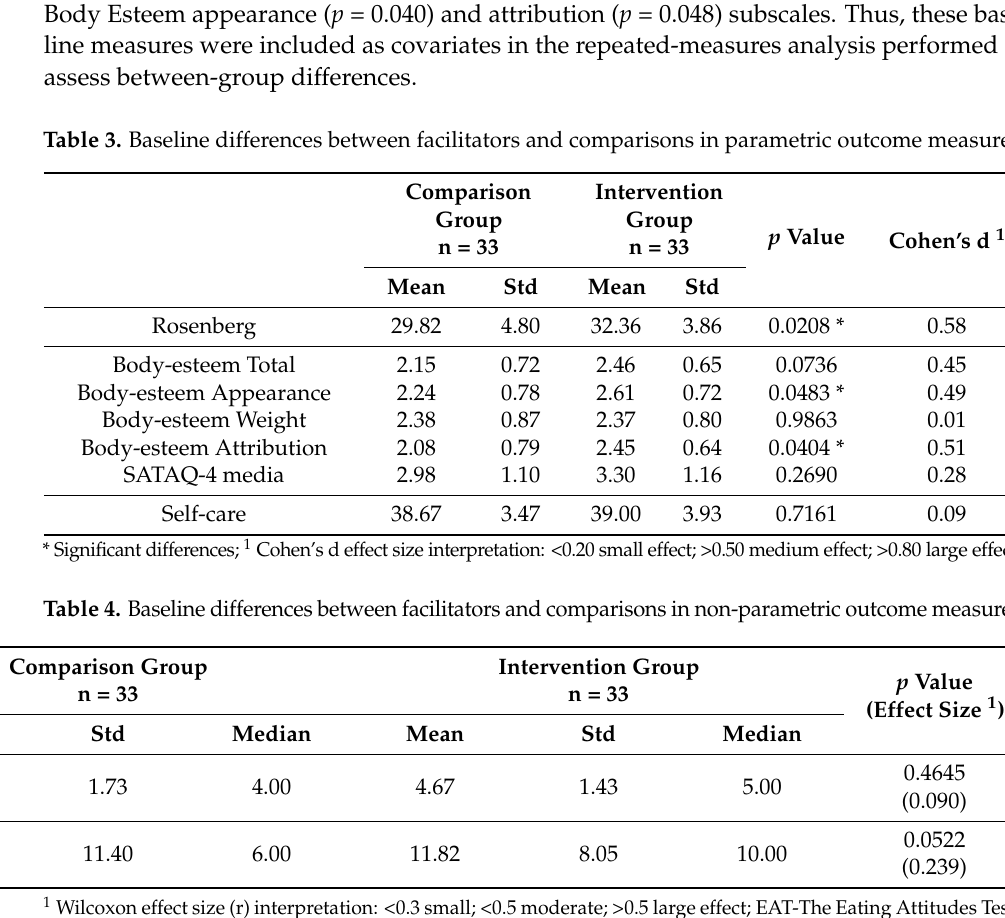
Table 3. Baseline differences between facilitators and comparisons in parametric outcome measures.